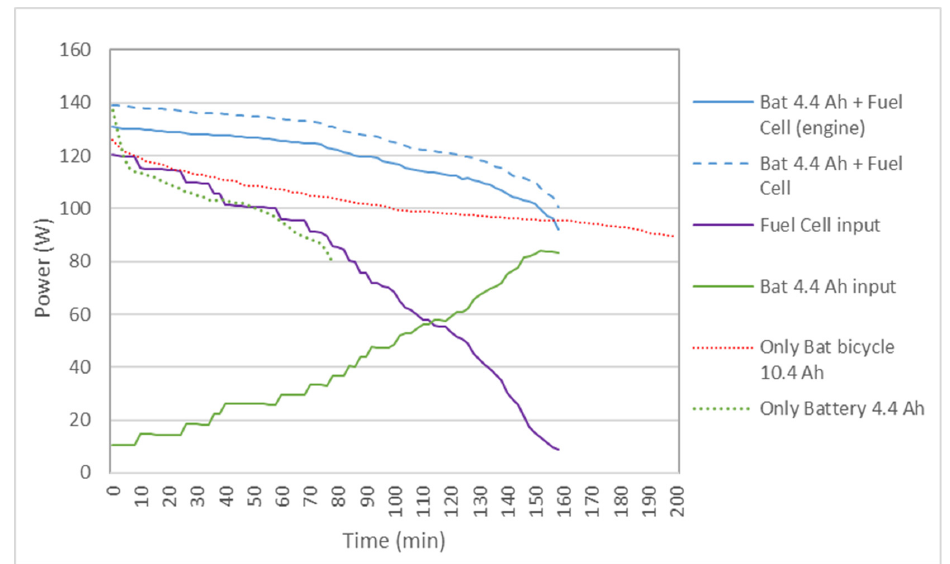
Figure 7. Comparison of the power delivered to the bicycle by the 4.4 Ah auxiliary battery and the 10.4 Ah battery acting alone, or the 4.4 Ah FC-battery hybrid system in the case of two reactors.